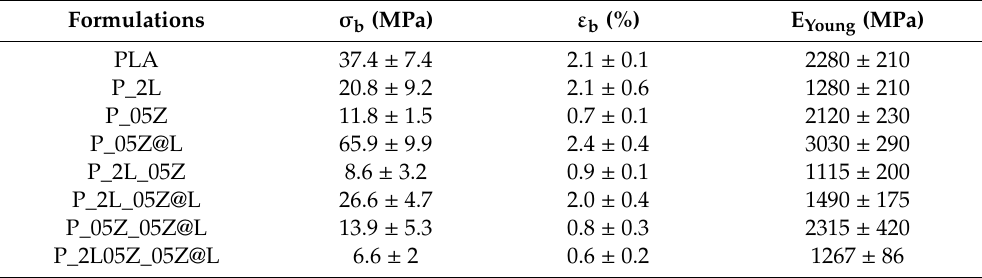
Figure 6. Stress-strain curves of PLA-based formulations. PLA, P-2L, P-05Z and P_05Z@L ( a ). PLA and P2L based nanocomposites ( b ). PLA, P-05Z, P_05Z@L and P-05Z_05Z@L ( c ). Comparison among PLA and PLA-based nanocomposites ( d ). Table 2. Mechanical properties of PLA-based